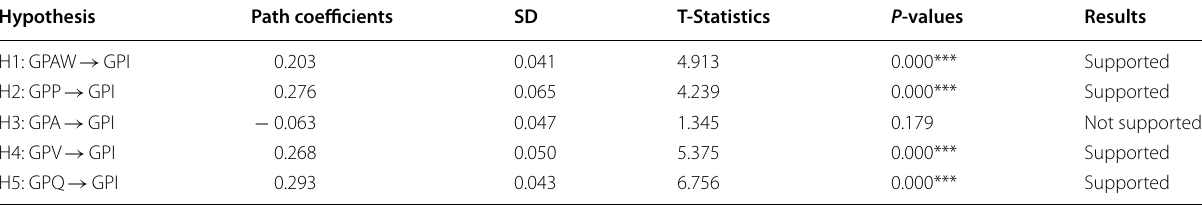
Table 7 Hypotheses testing